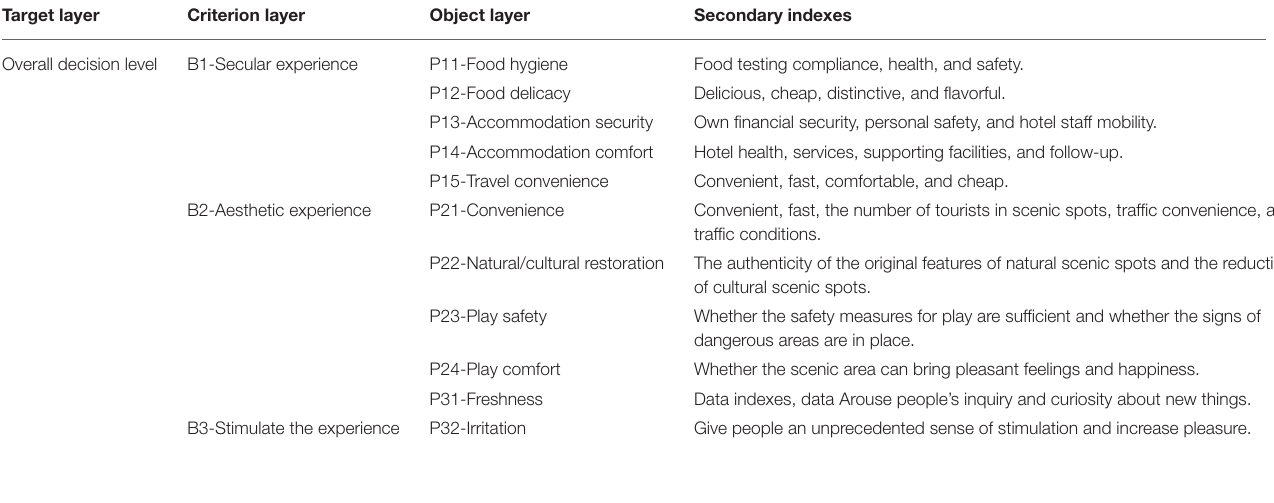
TABLE 1 | Construction of smart tourism index system based on tourist psychology.